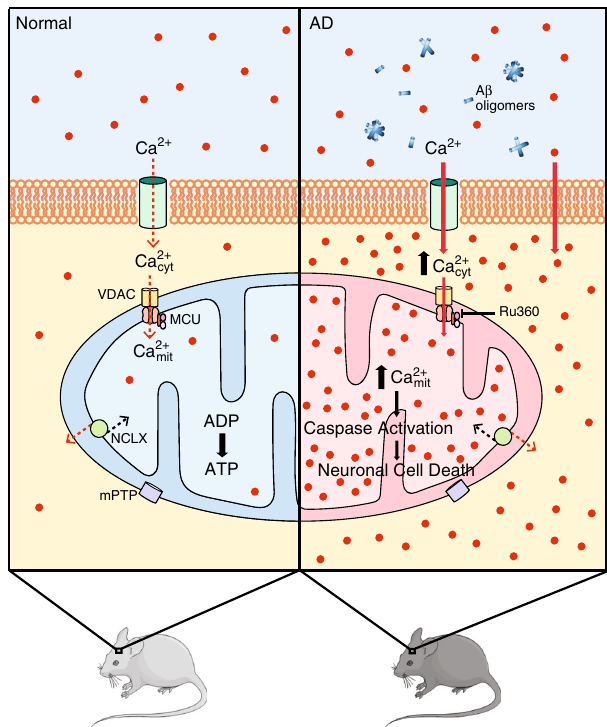
Fig. 8 Schematic representing the effects of A β aggregates on mitochondrial Ca 2 + homeostasis. Under physiological conditions (normal), mitochondria take up Ca 2 + from the cytosol, via mitochondrial Ca 2 + uniporter (MCU) complex, for activation of mitochondrial metabolism, TCA cycle and OXPHOS, leading to ATP production. However, under pathological conditions (AD), A β aggregates (likely soluble A β o) increase cytosolic Ca 2 + , thus leading to mitochondrial Ca 2 + overload. A β -induced mitochondrial Ca 2 + uptake is mediated via MCU, as blocking MCU with the speci fi c inhibitor Ru360 prevents it. Excessive Ca 2 + taken up by mitochondria could lead to opening of the mitochondrial permeability transition pore (mPTP), caspase activation and, eventually, neuronal cell death. This fi gure was created using modi fi ed Servier Medical Art templates, which are licensed under a Creative